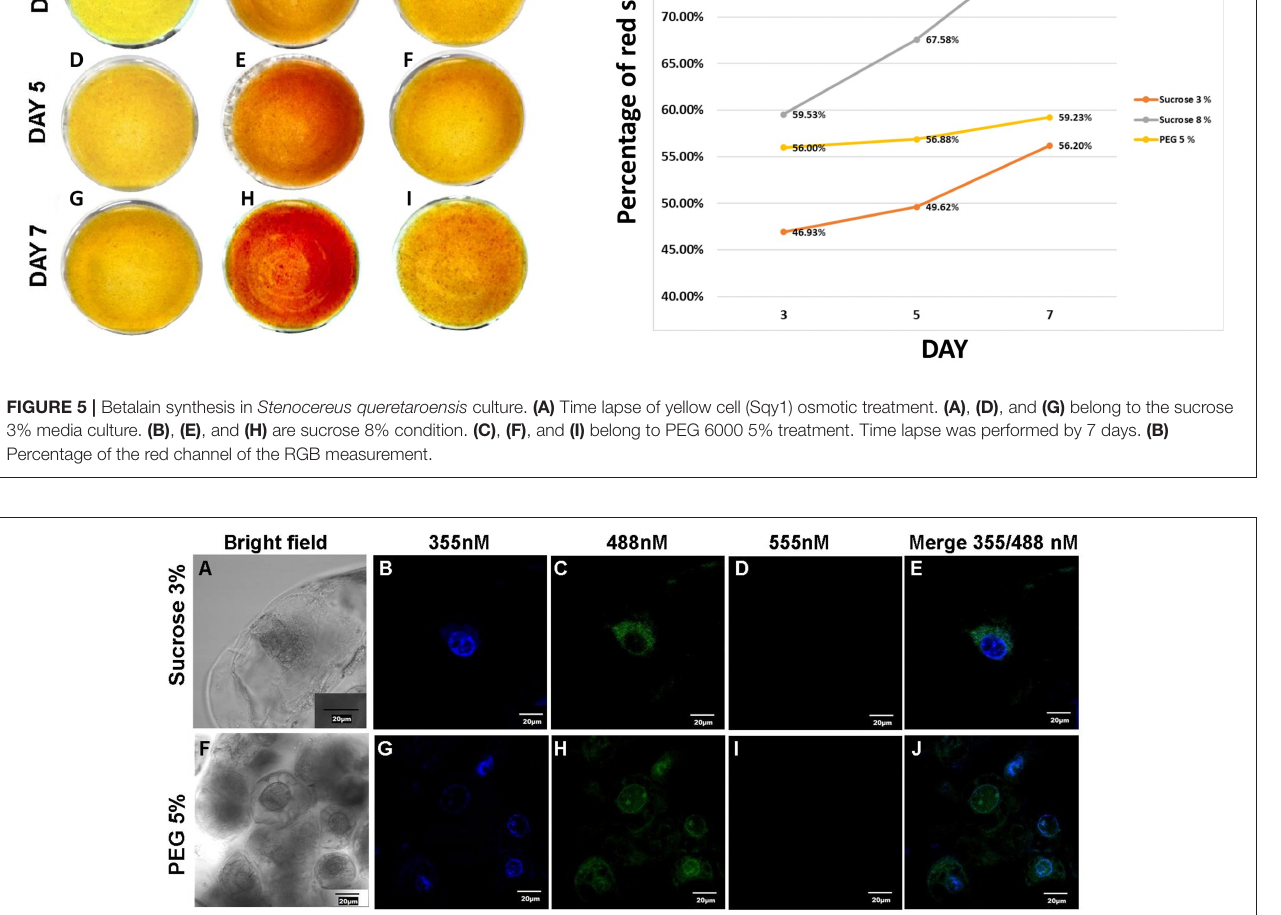
FIGURE 6 | In cell fluorescent detection of Stenocereus queretaroensis . (A,F) Bright field of culture cells, (B,G) DAPI stained signal at 355 nM, and (C,H) Autofluorescence Stenocereus queretaroensis culture cells at 488 nM as stated in the Materials and methods section. (D,I) lack of autofluorescence signal at 555 nM (E,J) . Merge of 355 and 488 channel. The cells were cultivated either in the absence of stress at 3% glucose or under osmotic stress with PEG 5%.